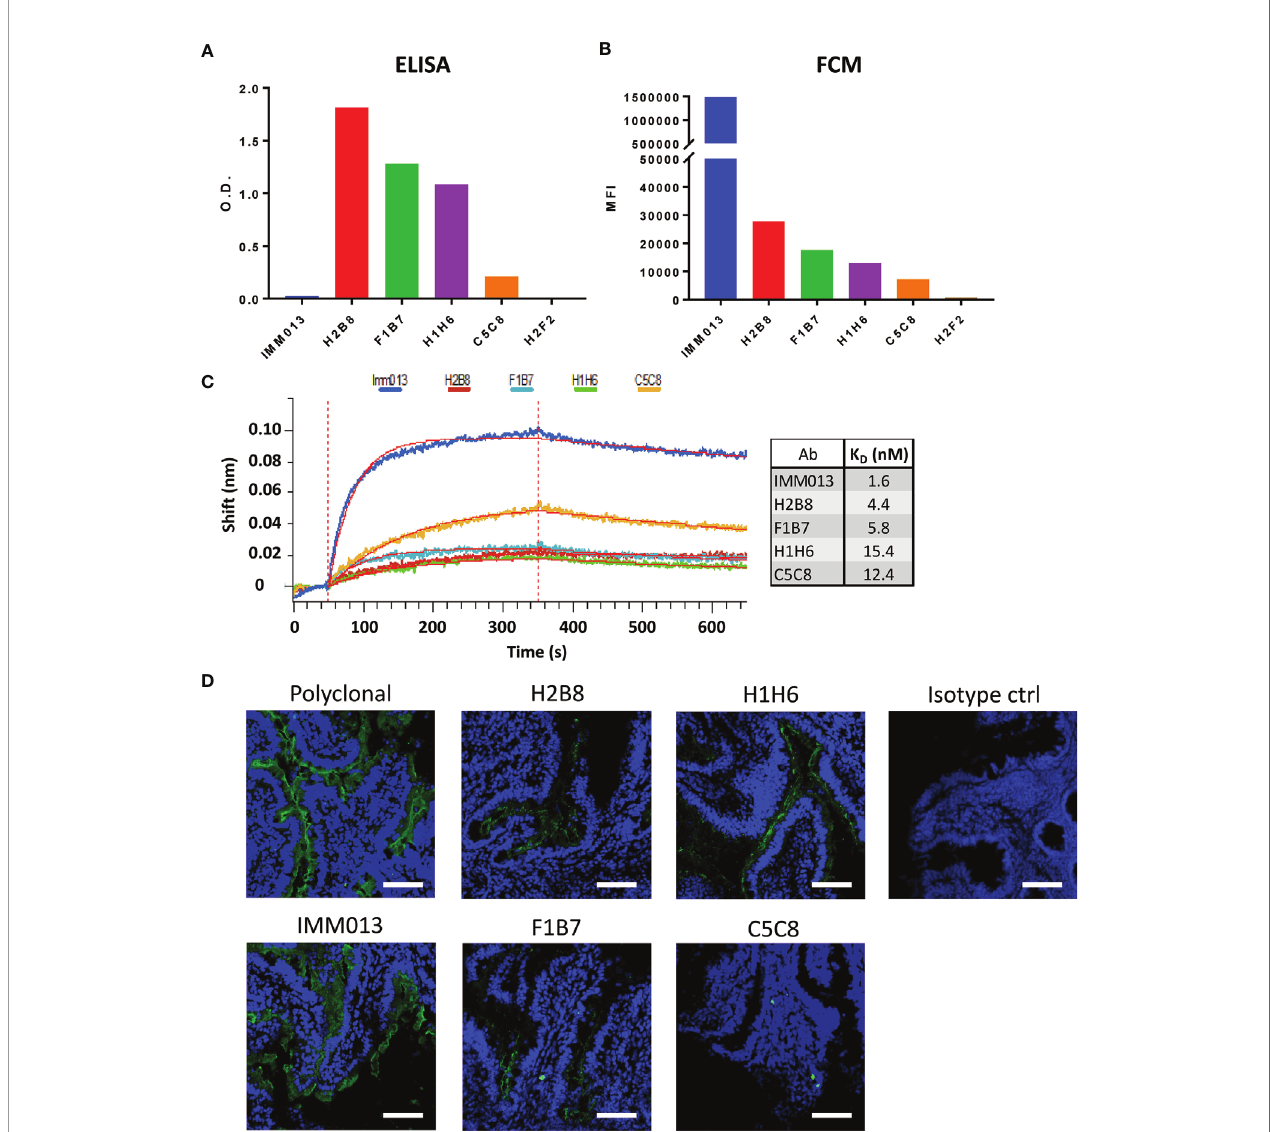
FIGURE 1 | Binding pro fi les of APN-speci fi c monoclonal antibodies to aminopeptidase N. Binding to porcine aminopeptidase N (APN) was analyzed using (A) enzyme-linked immunosorbent assay (ELISA) with puri fi ed kidney APN and (B) fl ow cytometry using an APN-expressing cell line. O.D.: Optical density; MFI: Mean fl uorescence intensity. O.D. values are subtracted from mean background absorbance. MFI values are subtracted from relevant isotype controls. (C) Binding kinetics of several mAbs using bio-layer interferometry (BLI) with resulting af fi nity (KD) values. Shift in wavelength (nm) is given over time (s). (D) Jejunal cryosections, stained with different antibodies and detected with a FITC-conjugated anti-mouse or anti-rabbit IgG (green). Mouse IgG1 and IgG2a antibodies were used as isotype controls. Nuclei were counterstained with Hoechst (blue). Data is representative for 3 animals. Scale bar = 100